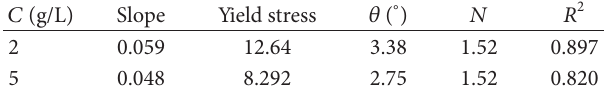
F 5: Huggins, Kraemer, Schulz-Blacschke, and Martin plots for FP gum. T 5: Some �ow parameters for FP